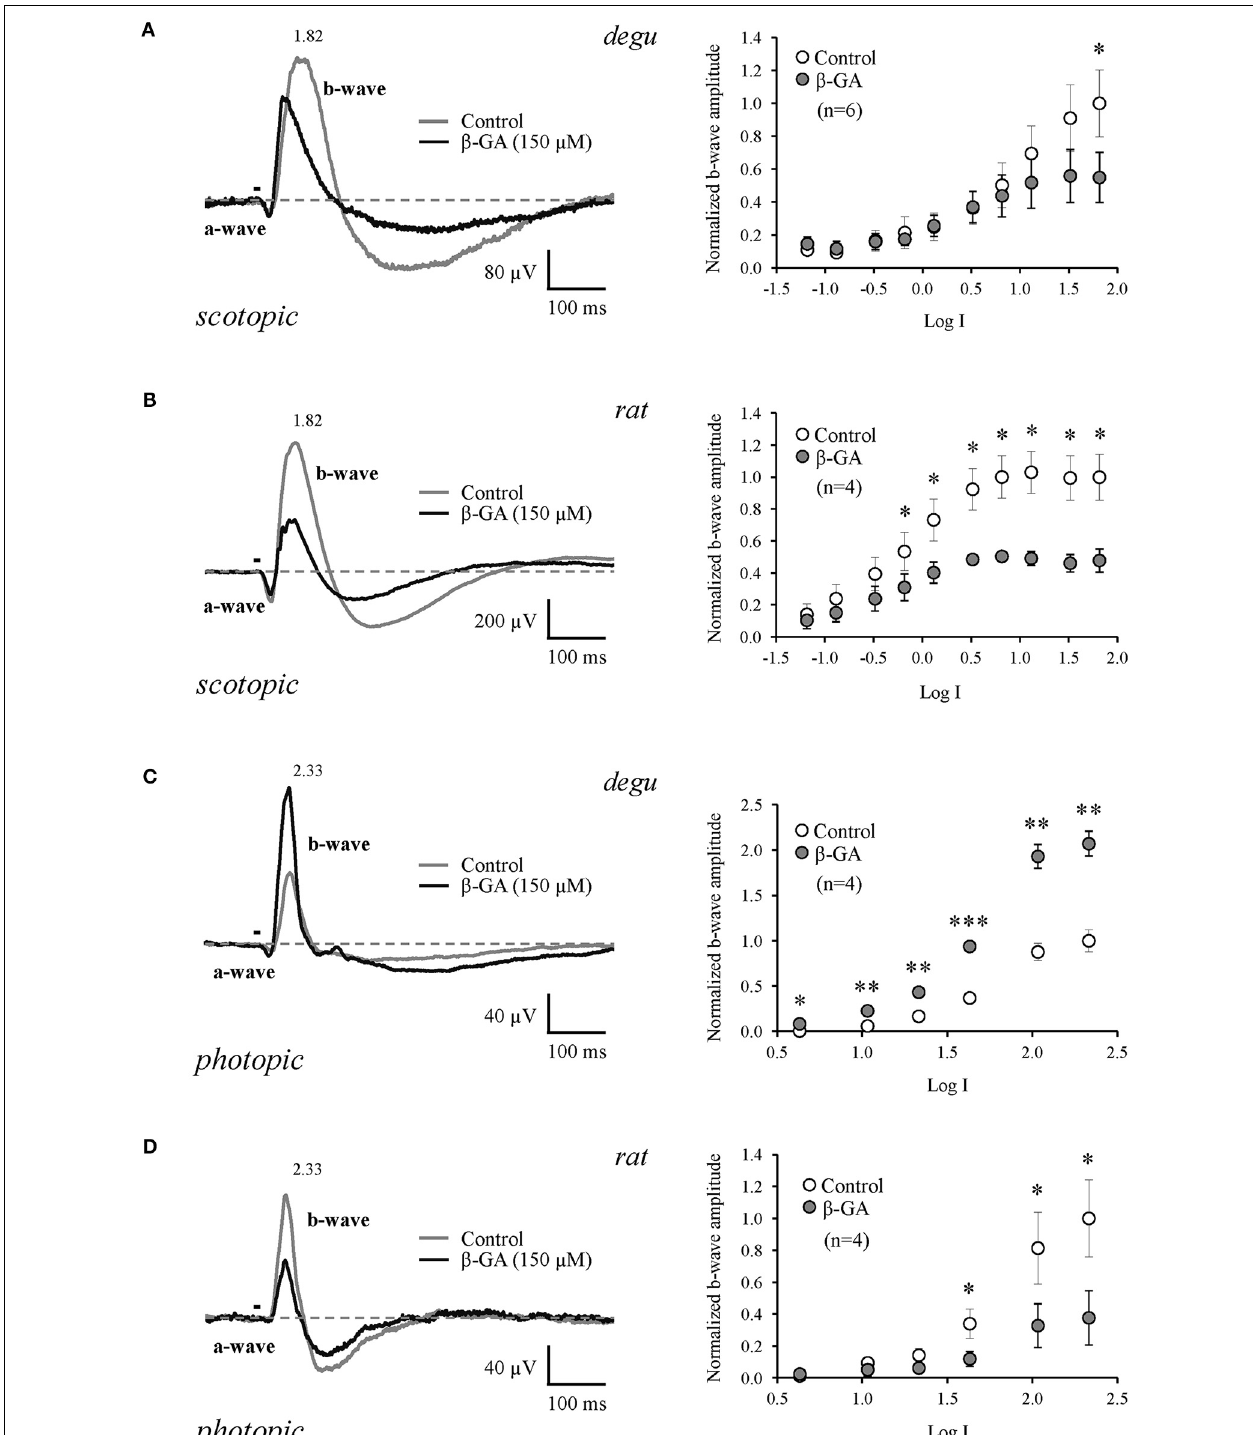
FIGURE 3 | Differential effect of connexin channel inhibition on the amplitudeoftheERGb-wave intheretinaofdeguandratduringdarkand light adapted conditions. Left: representative ERG tracers obtained from degu (A–C) and rat (B–D) eyes under control conditions or after treatment with β -GA (150 μ M), at the maximum intensity used. Bars indicate the stimulus